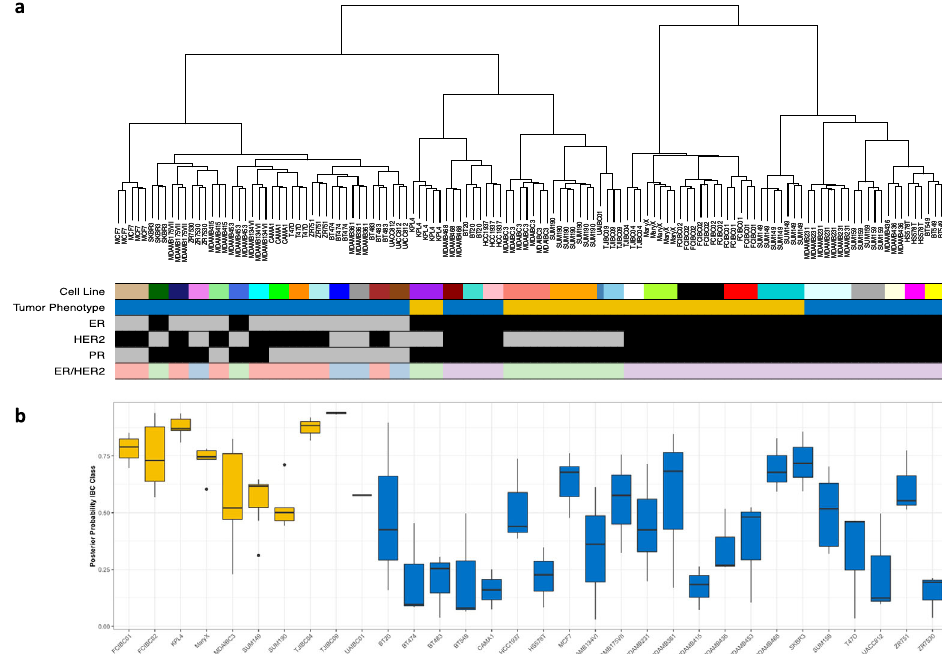
Fig. 1 Molecular characterization and classi fi cation of (in fl ammatory) breast cancer cell lines. a Dendrogram resulting from an unsupervised hierarchical cluster analysis performed on the normalized expression data set of preclinical models prior to averaging. The different cell lines are indicated using different colors in the annotation track underneath the dendrogram, in addition to the tumor phenotype (blue = nIBC; yellow = IBC), the ER status (gray = ER + ; black = ER − ), the HER2 status (gray = HER2 − ; black = HER2 + ), the PR status (gray = PR + ; black = PR − ), and the ER/HER2 combined subtypes (red = ER + /HER2 − ; green = ER − /HER2 + ; blue = ER + /HER2 + ; purple = ER − /HER2 − ). b The classi fi cation scores of the preclinical models are shown in boxplot format. The different preclinical models are shown along the X-axis and the Y-axis represents the posterior probability scores resulting from applying the IBC classi fi cation models. Boxes are color- coded according to the tumor phenotype: blue = nIBC and yellow =